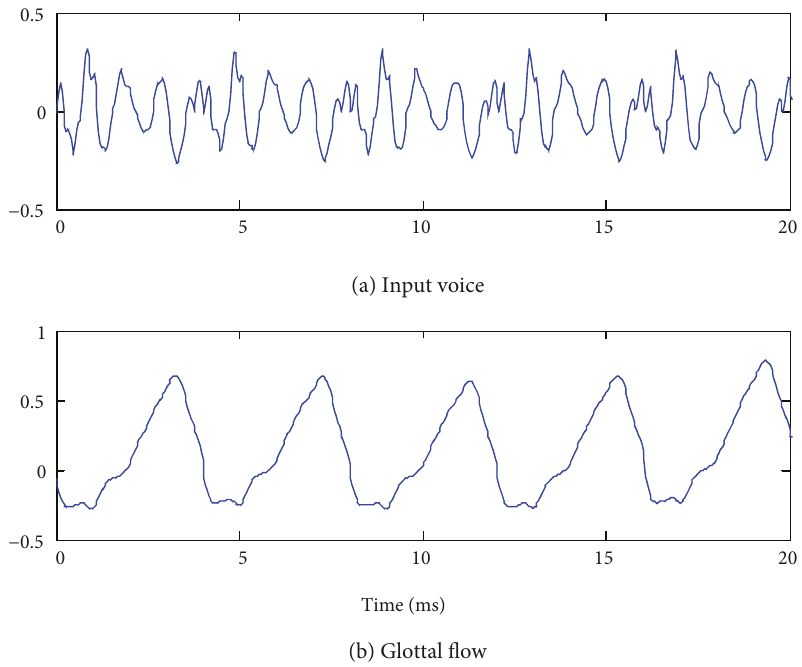
Figure 7: Example from vovel /a/ for a normal